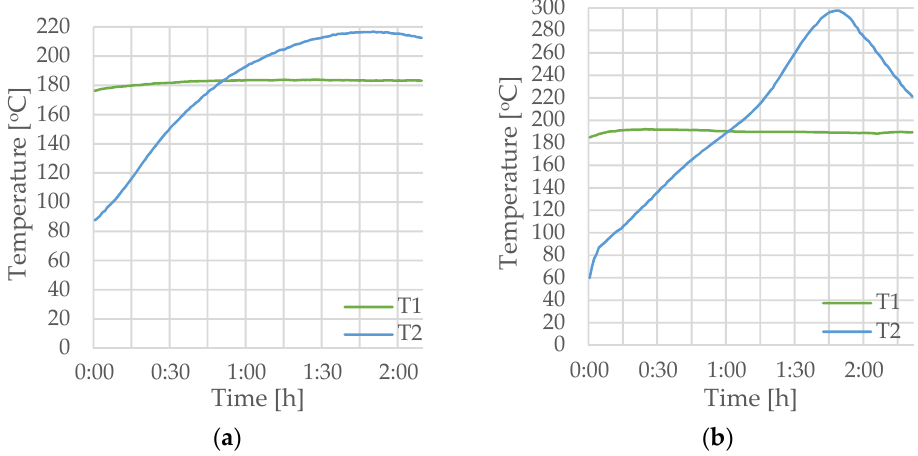
Figure 7. The temperature of sludge pellets in a 21.21 cm 3 basket: ( a ) at a furnace temperature of 186 °C with no evidence of dust ignition, ( b ) at a furnace temperature of 188 °C with a dust ignition.